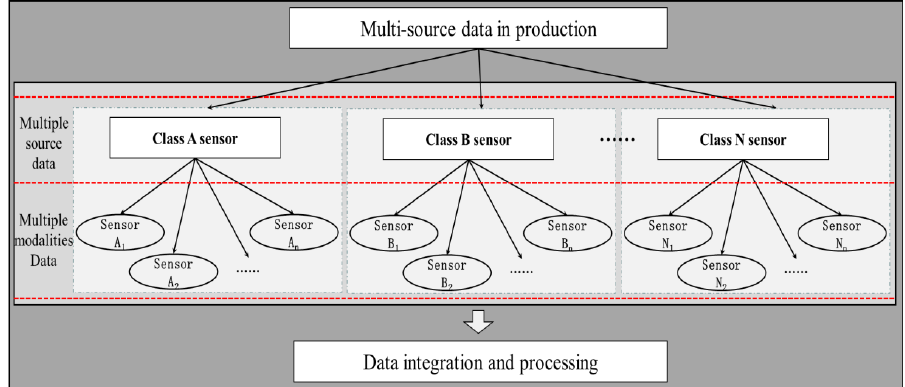
Figure 2. Correlating with multi-source data and multi-modal